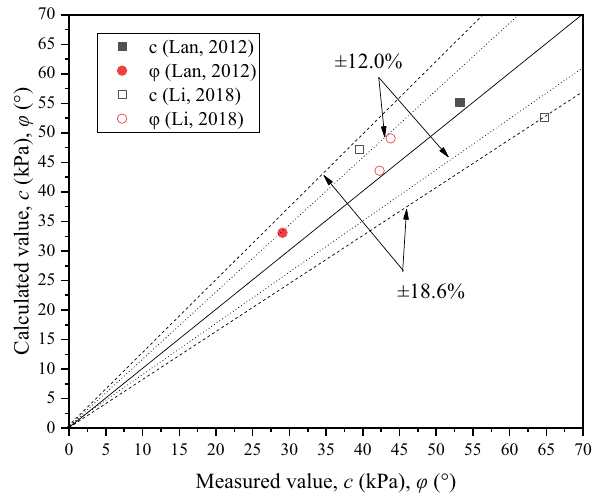
Figure 10. Comparison of calculated and measured cohesion and internal friction